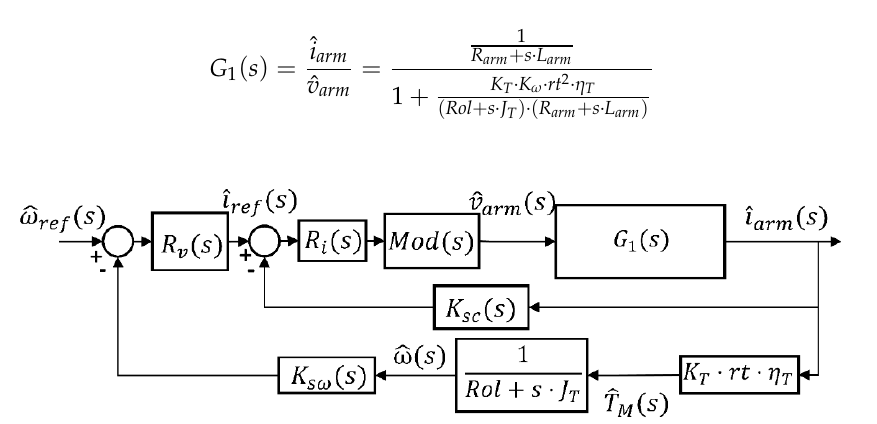
Figure 8. Block diagram of the modified small-signal model.